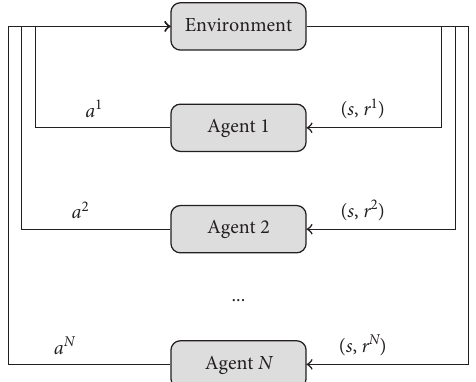
Figure 14: Schematic diagram of Markov games.